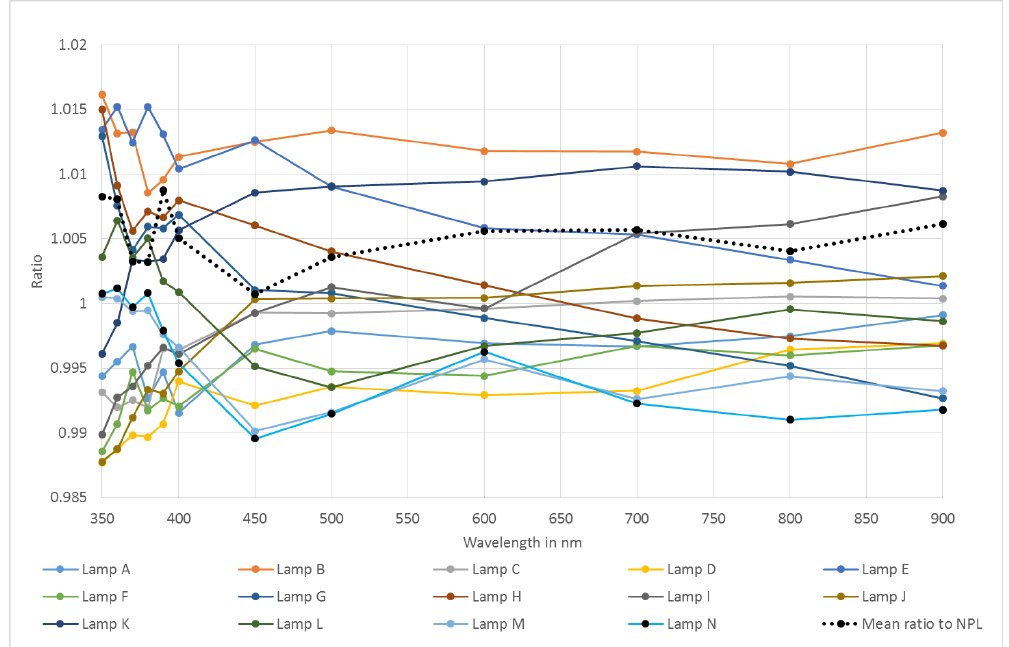
Figure 4. The results of the lamp irradiance comparison. Coloured lines represent the results of each lamp compared to the mean of all lamps. The dotted line compares the mean of all lamps to National Physical Laboratory’s (NPL) SI-traceable